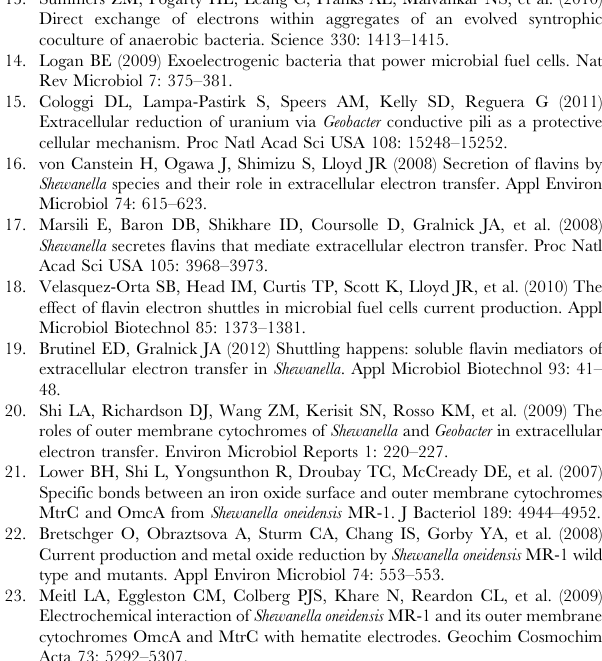
Figure S4 Effect of DMS on HFO reduction by S oneidensis MR-1. 20 mM DMS was dosed into serum vials in HFO reduction. Control was set as no cells to evaluate possible abiotic reduction of HFO by DMS. Figure S5 Effect of DMS on electricity generated by the WT. Bacterial cells were inoculated to the OD 600 of 0.5. The potential of working electrodes was set at + 0.15 V (versus Ag/ AgCl). DMSO and DMS were dosed at 0.5 mM. Electrochemical cells dosing DMSO or DMS and without cultures were set as controls. The experiments were repeated twice. Figure S6 Lactate consumption and acetate production at 48 h of HFO reduction. The medium was supplemented with 50 mM lactate for HFO reduction. 20 mM DMSO was also added when